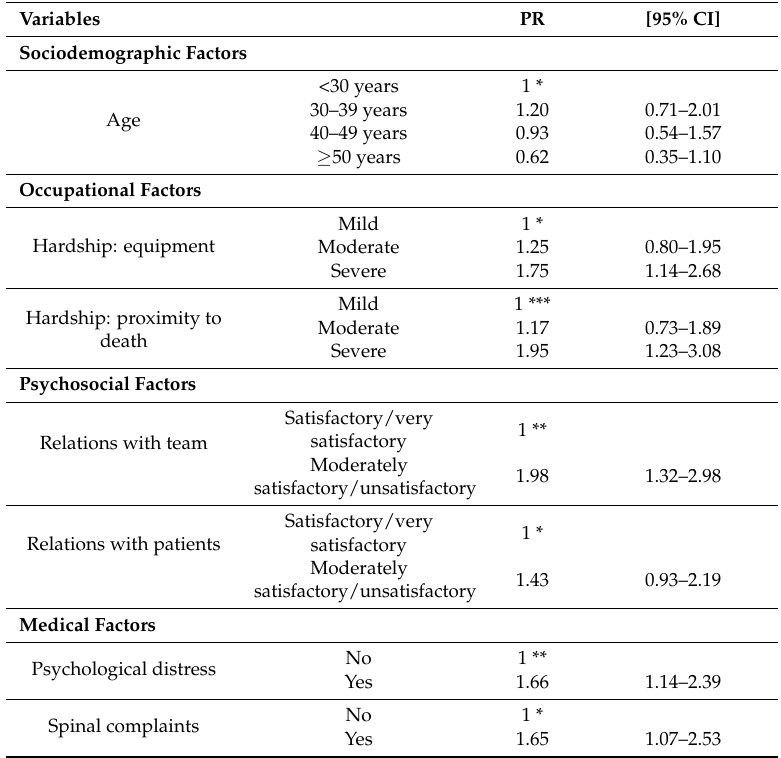
Table 3. Significant associations between registered nurses’ intention to leave work with the elderly and sociodemographic, occupational, psychosocial and medical factors on intermediate multivariate